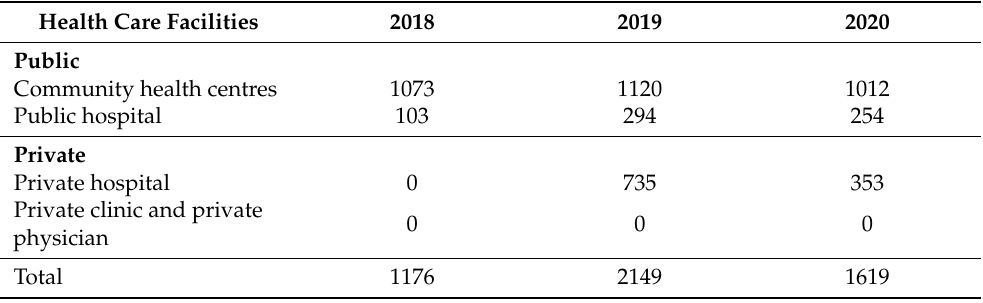
Table 3. TB case notification in Purwakarta